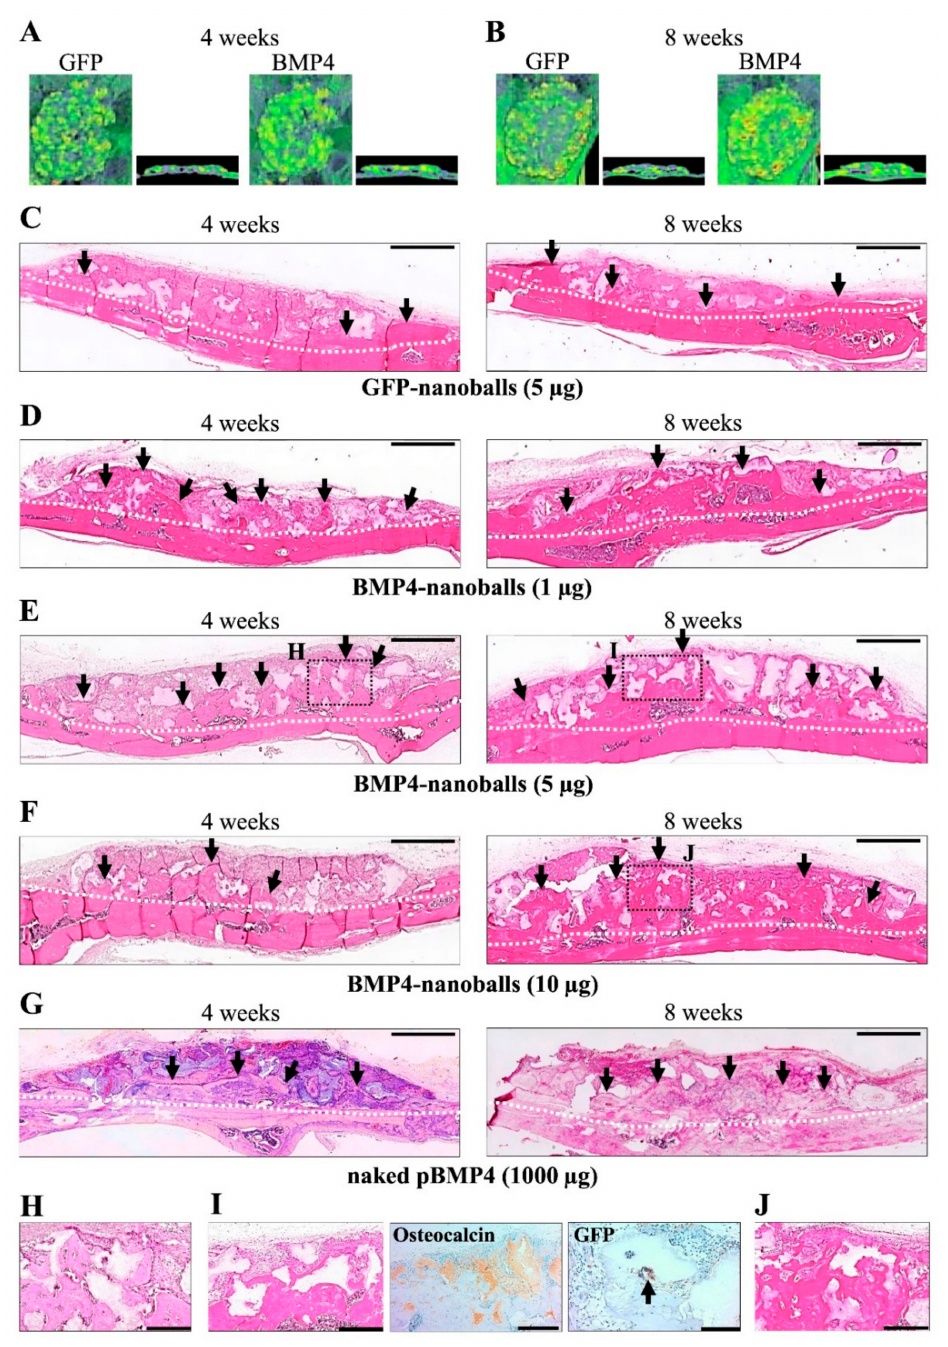
Figure 7. Micro-CT and histological appearances of augmented bone at 4 and 8 weeks after GAM transplantation ( n = 5 per group, respectively). ( A , B ) Representative images (axial and sagittal views) of micro-CT in specimens of GAM with GFP-nanoballs and BMP4-nanoballs. ( C – G ) Representative images (H&E staining) of augmented bone tissues in GAM specimens with 5 µ g of GFP-nanoballs ( C ), 1 µ g of BMP4-nanoballs ( D ), 5 µ g of BMP4-nanoballs ( E ), 10 µ g of BMP4-nanoballs ( F ), or 1000 µ g of naked pBMP4 ( G ). Scale bar, 1 mm; white dotted line, boundary of the cranium and newly formed bone; black arrow, augmented bone area. ( H – J ) The black box areas in ( E , F ) are shown at higher magnifications. ( I ) Osteocalcin and GFP expressions in a specimen of ( E ) at 8 weeks. Scale bar is 200 µ